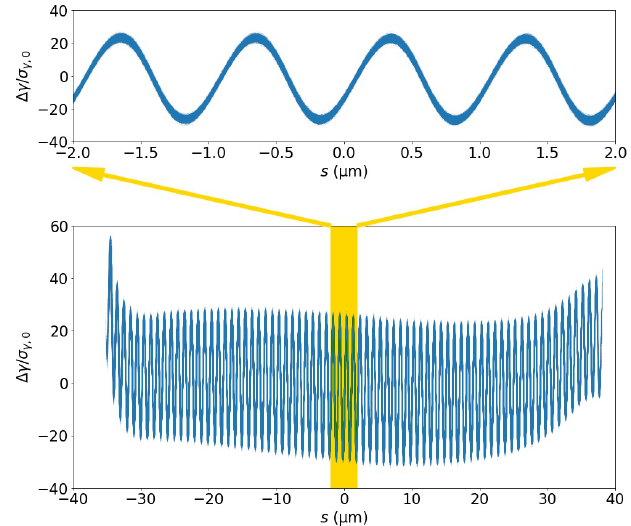
Figure 3. Energy modulation contrast ratio of the entire beam downstream of the laser modulator. The central section of the plot that is shaded in yellow is expanded and provided at the top, showing the details of the electron beam energy